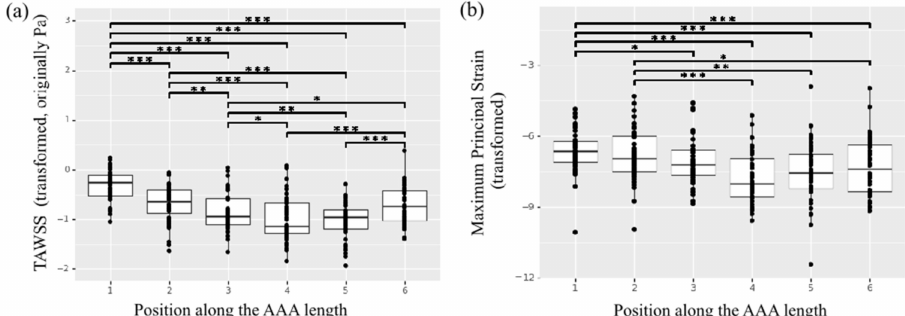
Figure 8. Heterogeneity of the in vivo properties along the length of the AAA. ( a ) TAWSS. ( b ) Maximum principal strain. * indicates p value < 0.05, ** indicates p value < 0.01 and *** indicates p value < 0.001.